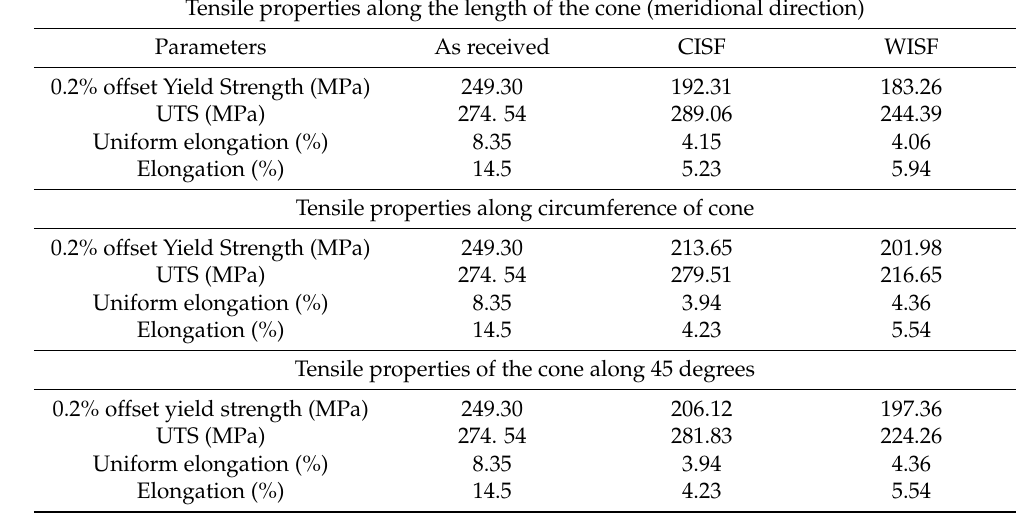
Table 10. Effect of orientation on tensile properties of the cone formed by CISF and WISF. Tensile properties along the length of the cone (meridional direction) Parameters As